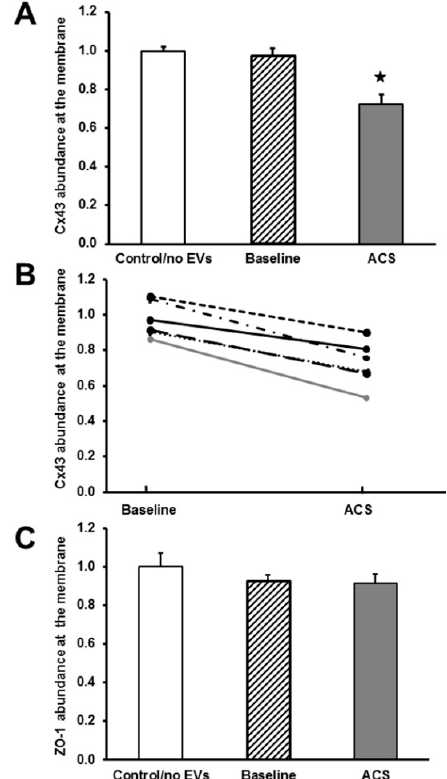
Figure 3. Comparison of membrane staining of Cx43 and ZO-1 in endothelial cells after treatment with ACS plasma-derived EVs. Endothelial cells were grown to confluence and then treated for 48 h with no EVs ( n = 1), EVs from controls ( n = 2), EVs from subjects with SCD at baseline ( n = 6), or EVs from the same subjects during an ACS episode ( n = 6). ( A ) Graph shows intensity of Cx43 at the membrane normalized to the average values in control/no EVs treated cells ( n = 3). There was a dramatic reduction of Cx43 intensity at the membrane in endothelial cells treated with EVs from ACS samples ( 🟊 , p < 0.05 as compared to baseline EV treated cells). ANOVA, followed by a Tukey post-hoc test, showed significant differences between control/no EVs and ACS as well as between baseline and ACS, ( 🟊 , p < 0.05). Control/no EVs and baseline were not significantly different ( p > 0.05). ( B ) Graph shows intensity of Cx43 staining at the membrane in individual subjects at baseline or during ACS (with results from the same subject connected by lines, referring to baseline and ACS episode as a pair of results for the same subject). 6 different forms of lines are used to distinguish between 6 different subjects. In all 6 subjects, EVs isolated during ACS decreased the Cx43 intensity at the membrane compared to EVs isolated during baseline. ( C ) Graph shows intensity of ZO-1 at the membrane normalized to the average values in control/no EVs. None of these values were significantly different.